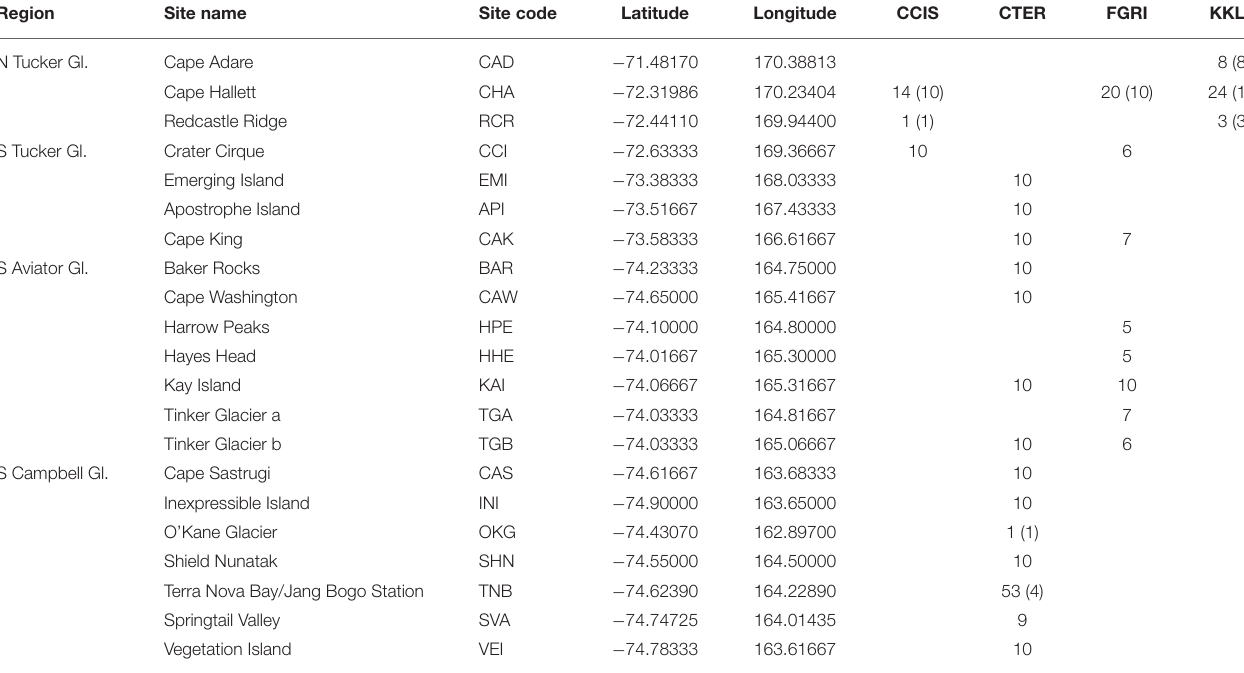
TABLE 2 | Collection sites in northern Victoria Land, grouped by region, including the number of COI sequences at each site for the four species in this area; Cryptopygus cisantarcticus (CCIS), Cryptopygus terranovus (CTER), Friesea grisea (FGRI), and Kaylathalia klovstadi (KKLO). Region N Tucker Gl.